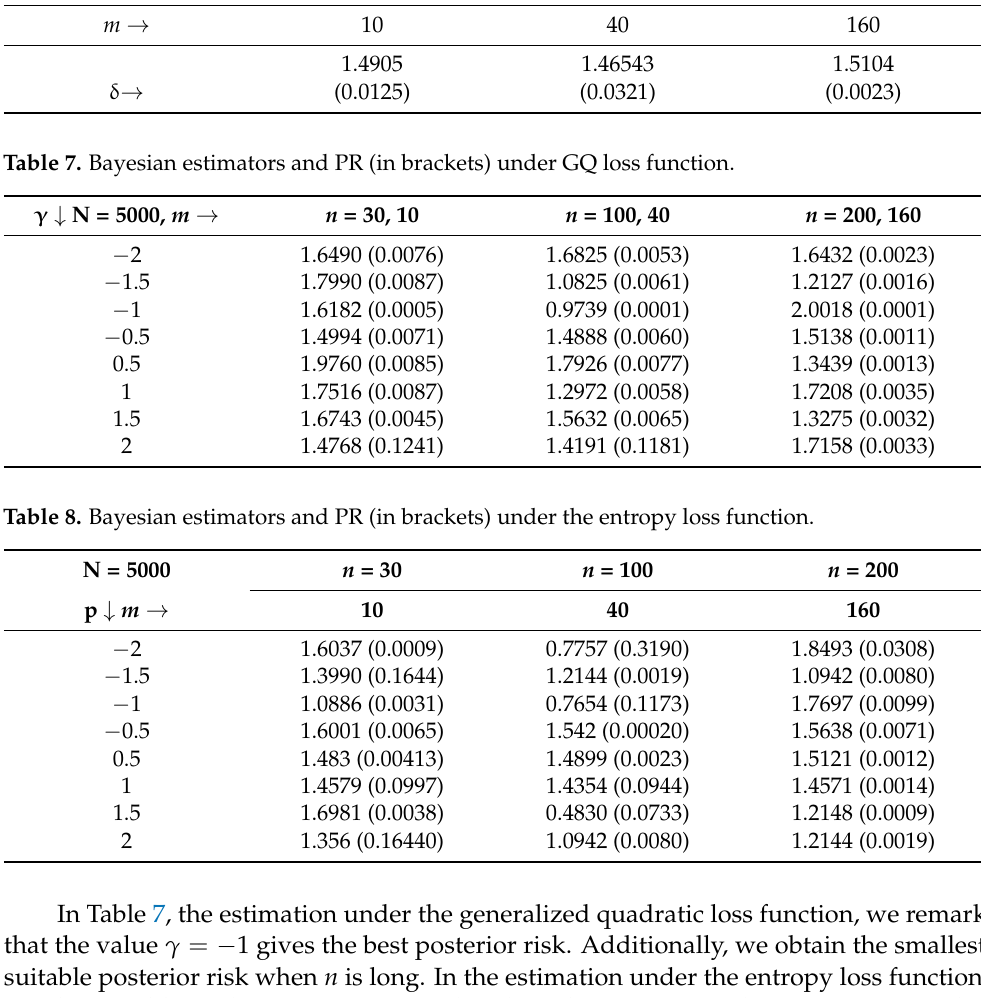
Table 10. The best Bayesian estimators and maximum likelihood estimators should